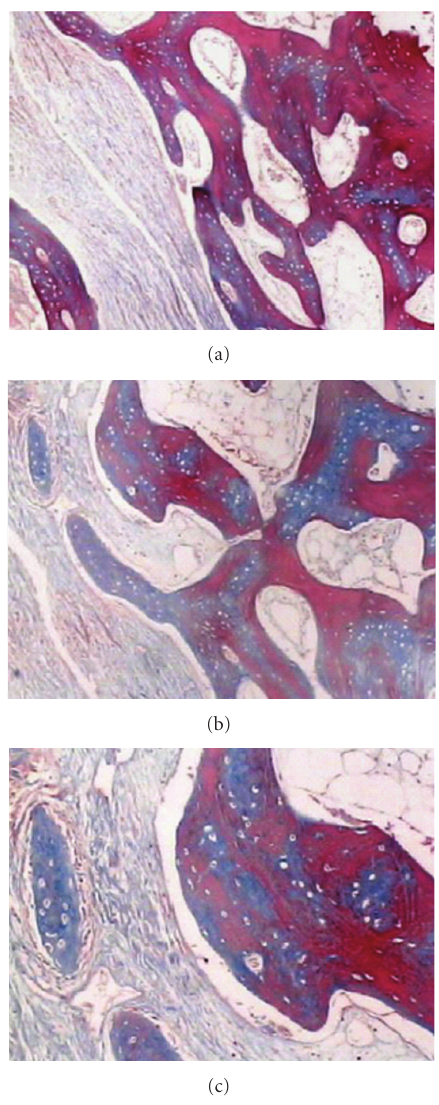
Figure 6: Images showing bone growth in di ff erent areas of the sample, with 40x magnification ((a)-(b)) and a 100x magnification (c). We can see the formation of fibers surrounding the “islands” of ossification. Masson’s trichrome